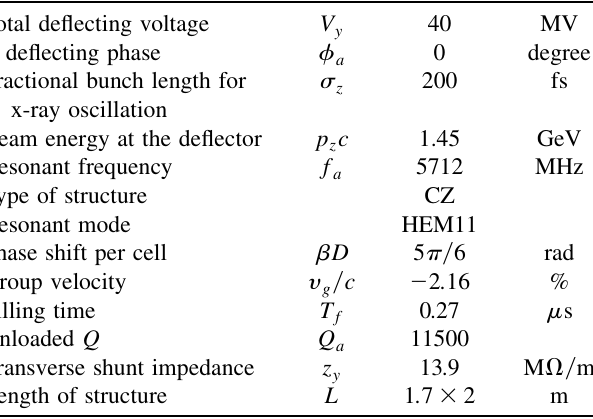
TABLE II. Rf specifications of the RFDEF.